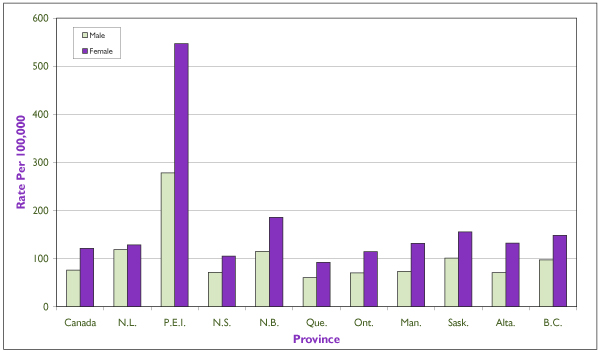
Hospital admissions for depression, by sex and province (age ≥ 15 years), 1999 Source: Hospital Morbidity Database, 1998–1999